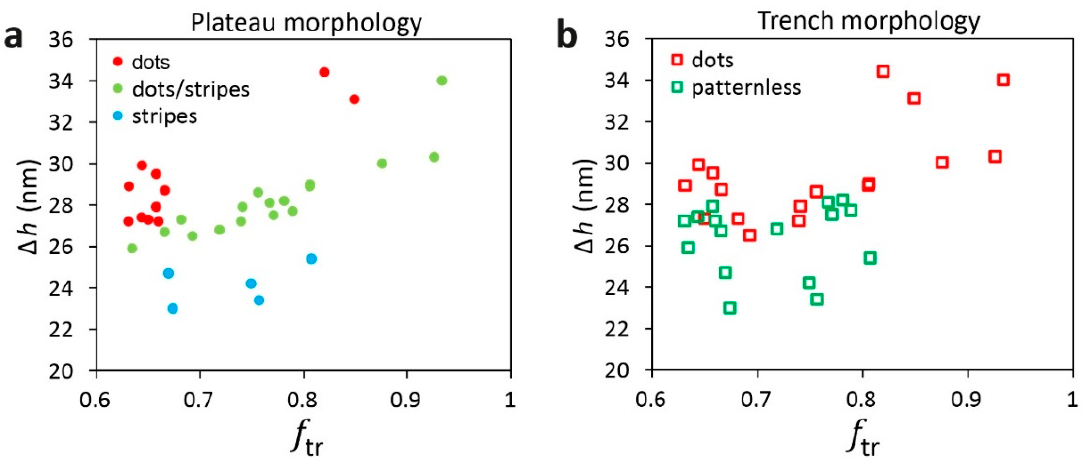
Figure 4. Phase diagrams of the morphologies of lamellar PS- b -PMMA cast over topographically patterned substrates with 38 nm-deep trenches: ( a ) patterns that develop on the plateaus; ( b ) pat- terns that develop in the trenches.